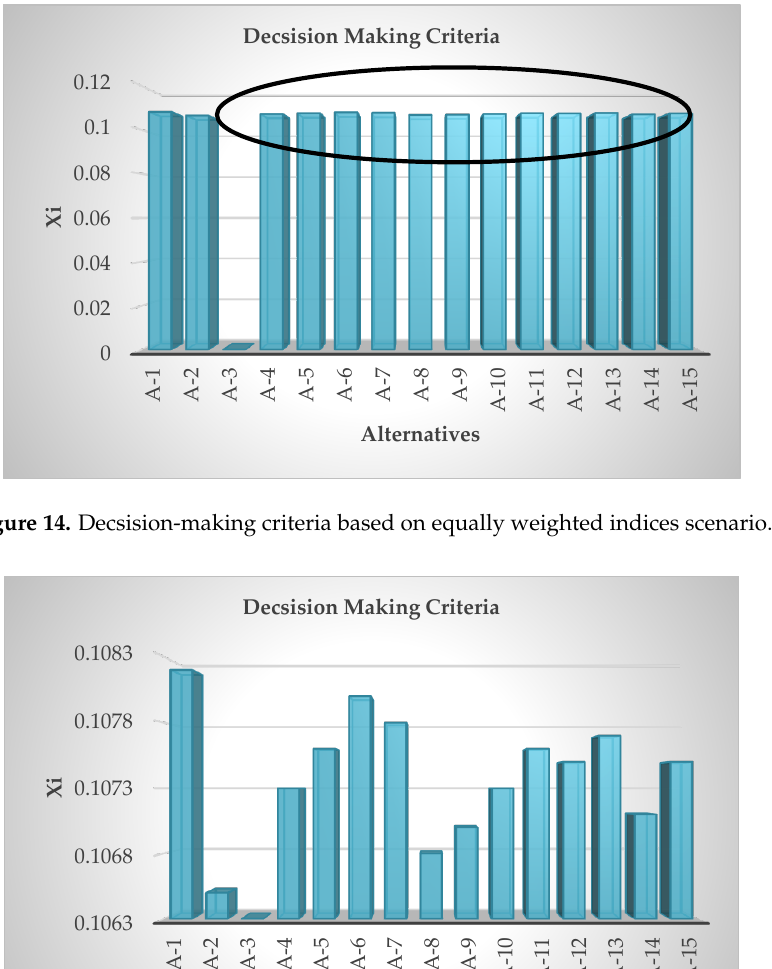
Figure 13. CO 2 Emission index of each alternative. Energies 2018 , 11 , x FOR PEER REVIEW